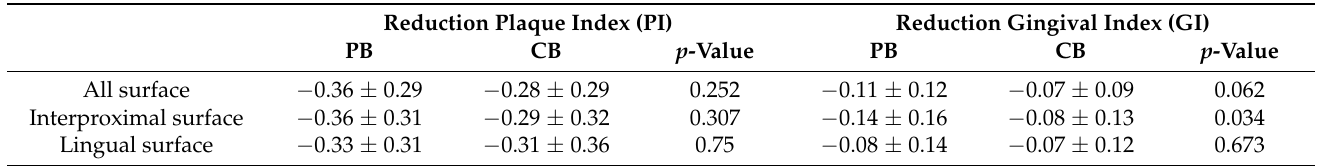
Table 3. Comparison of difference between plaque index (PI) and gingival index (GI) before and after brushing by toothbrush type: mean score (standard deviation) for all, interproximal, and lingual